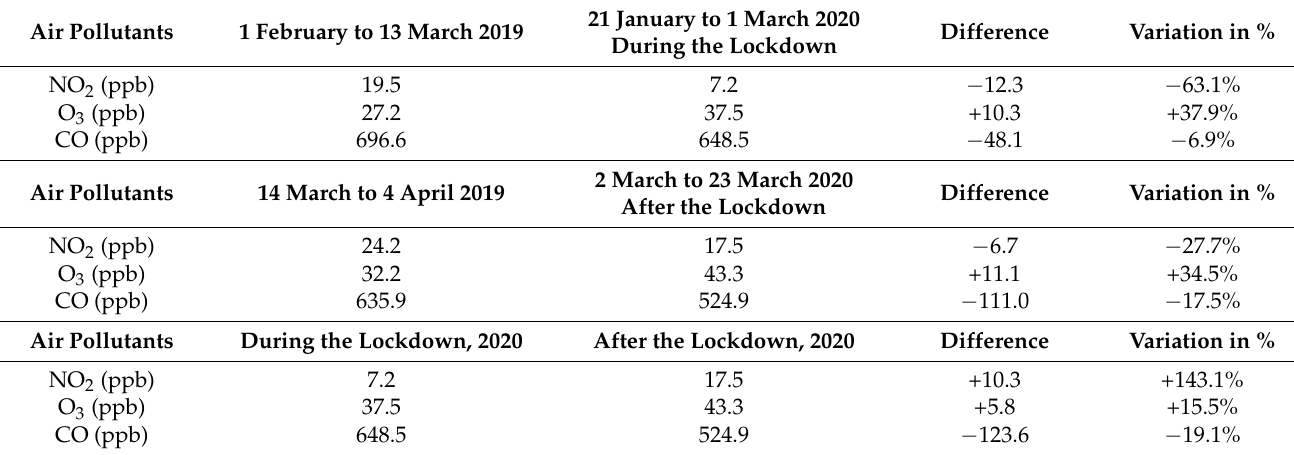
Table 5. The comparison of the concentrations of NO 2 , O 3 and CO between 2020 and 2019. The years 2020 and 2019 were compared according to the same lunar period. The period from 21 January to 1 March in 2020 was during the lockdown, and the period from 2 March to 23 March in 2020 was after the